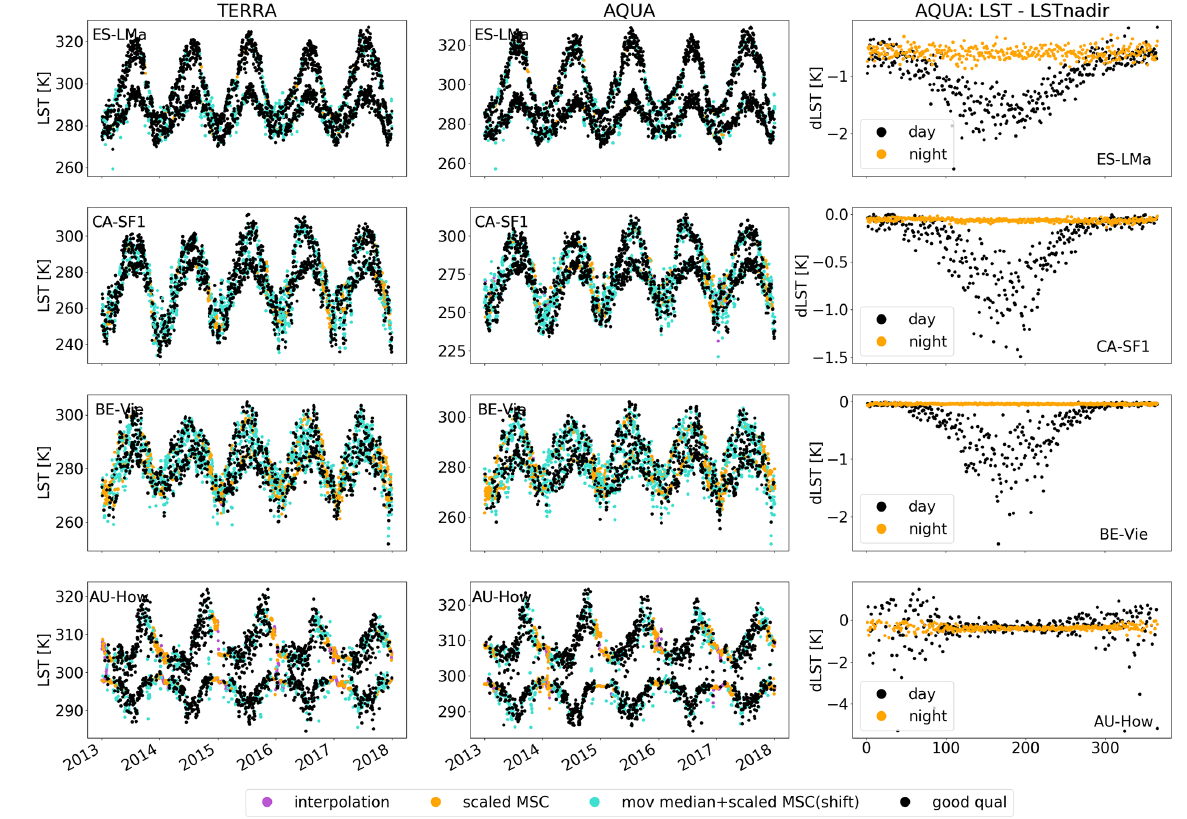
Figure 6. MODIS LST gap-filling steps in the 1km pixel containing selected eddy-covariance sites for daytime and nighttime LST. The rightmost column shows the average annual cycle of the correction factor between LST from variable viewing angles and LST corrected to nadir